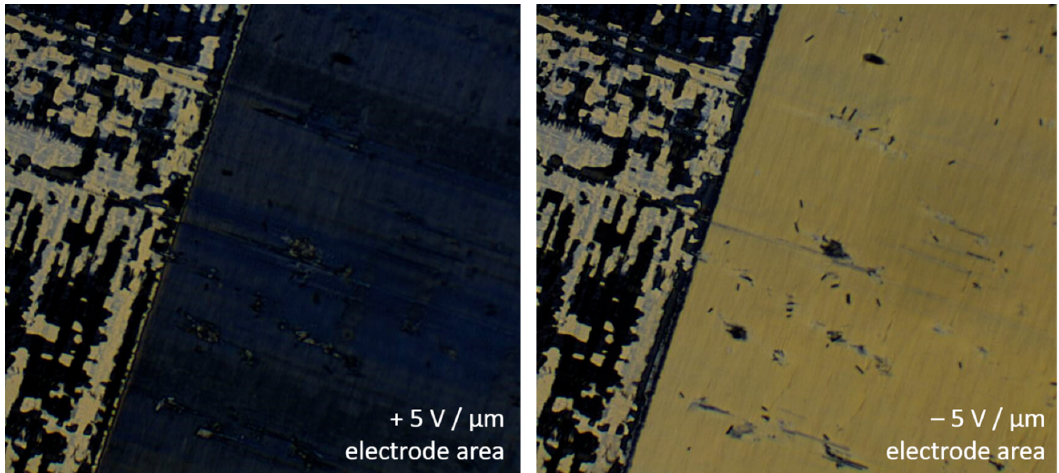
Figure 14. Polar electro-optic effect of a lyotropic SmC* phase in the SSFLC geometry ( 4 with 20 wt% formamide at 28 °C in a 1.6 µm thick cell). The directions of the spontaneous polarization and director tilt depend on the sign of the applied electric field. Therefore, the transmittance of the sample depends on the sign of E . Outside the electrode area (upper left corner) the tilt domain texture of the virgin sample can be seen.